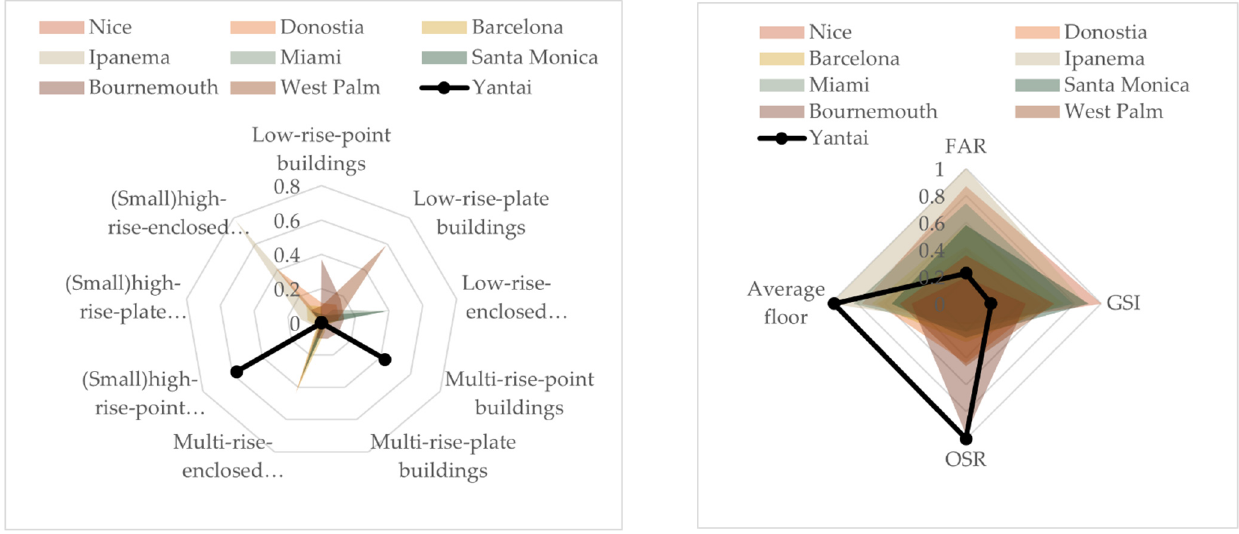
Figure 19. The suggestions for the typology and the development intensity.